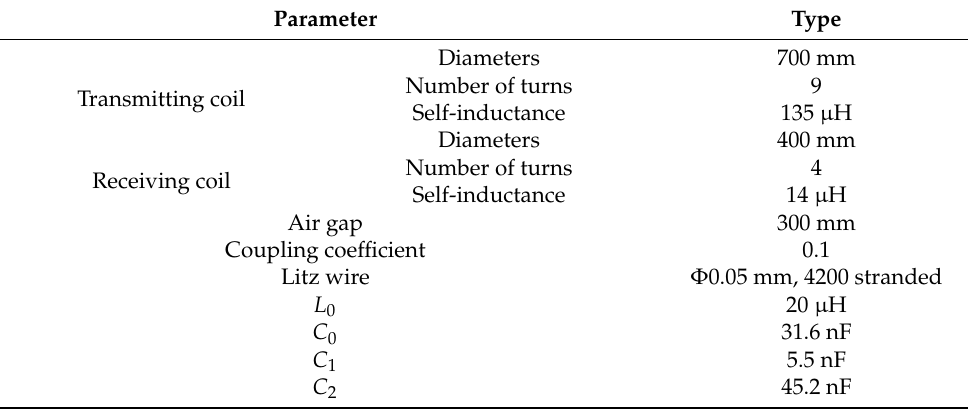
Table 3. Detailed coil parameters.